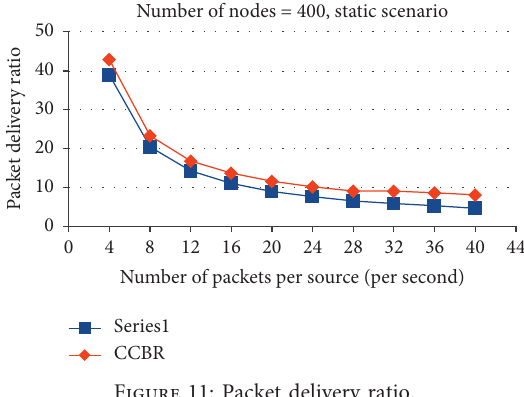
Figure 11: Packet delivery ratio.